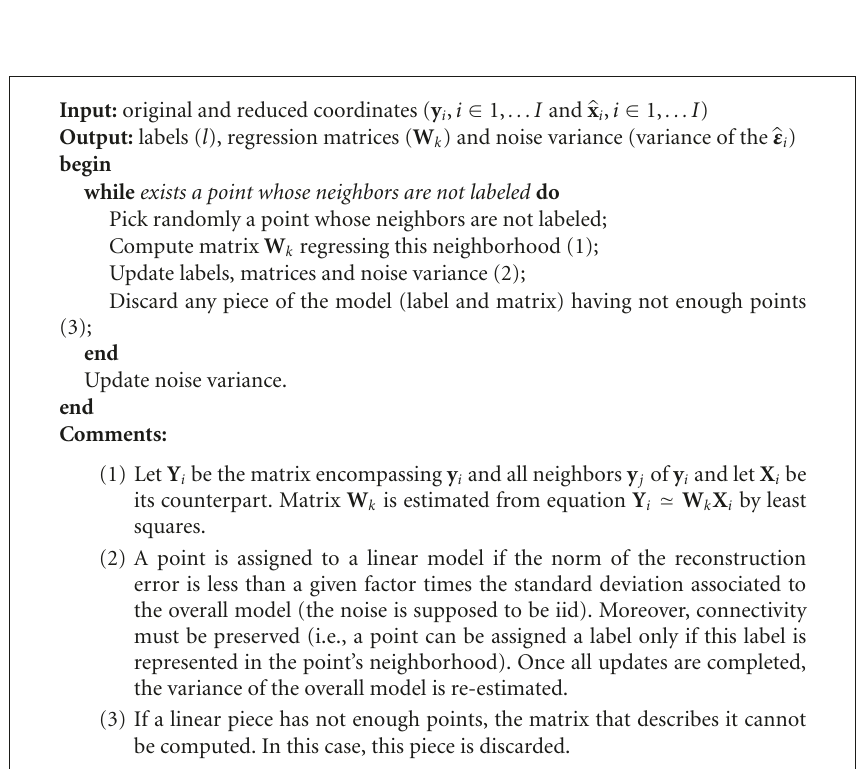
Algorithm 3: Piecewise linear mapping 1 (PLM